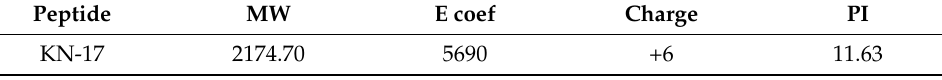
Table 2. Molecular characteristics of KN-17.